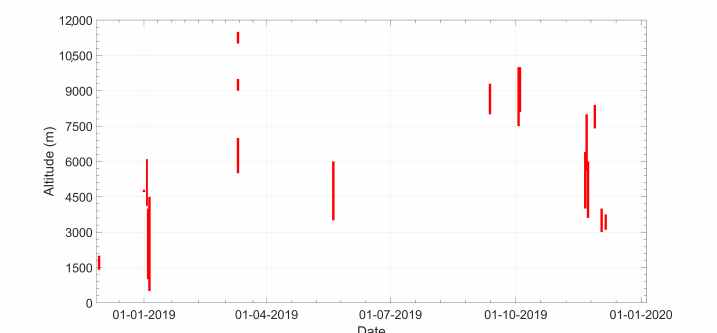
Figure 10. Occurrence and height boundaries of lofted aerosol layers in Punta Arenas between 27 November 2018 and 31 December